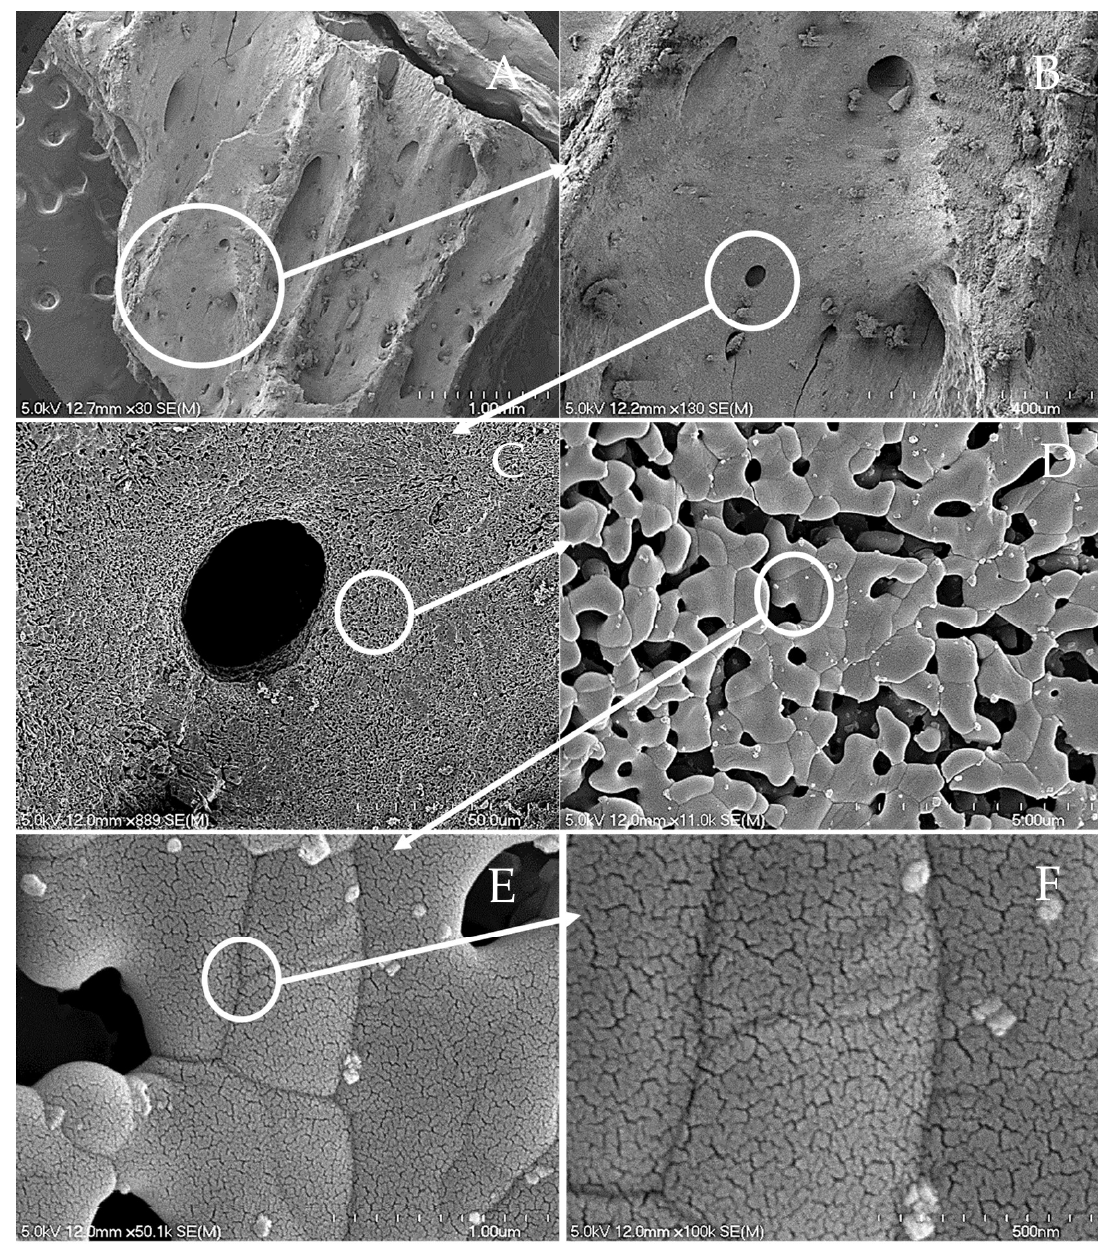
Figure 4. A series of SEM images of surface morphology of high temperature sintered bovine rib bone; ( A ) a particle of bovine bone-derived (CNF)/hydroxyapatite (HAp), ( B , C ) presents one of the interconnected pores, ( C – E ) presents surface imaging of a HAp particle & ( F ) depicts surface sub-micron cracks on the surface of HAp. These materials were generated by one of the review’s authors